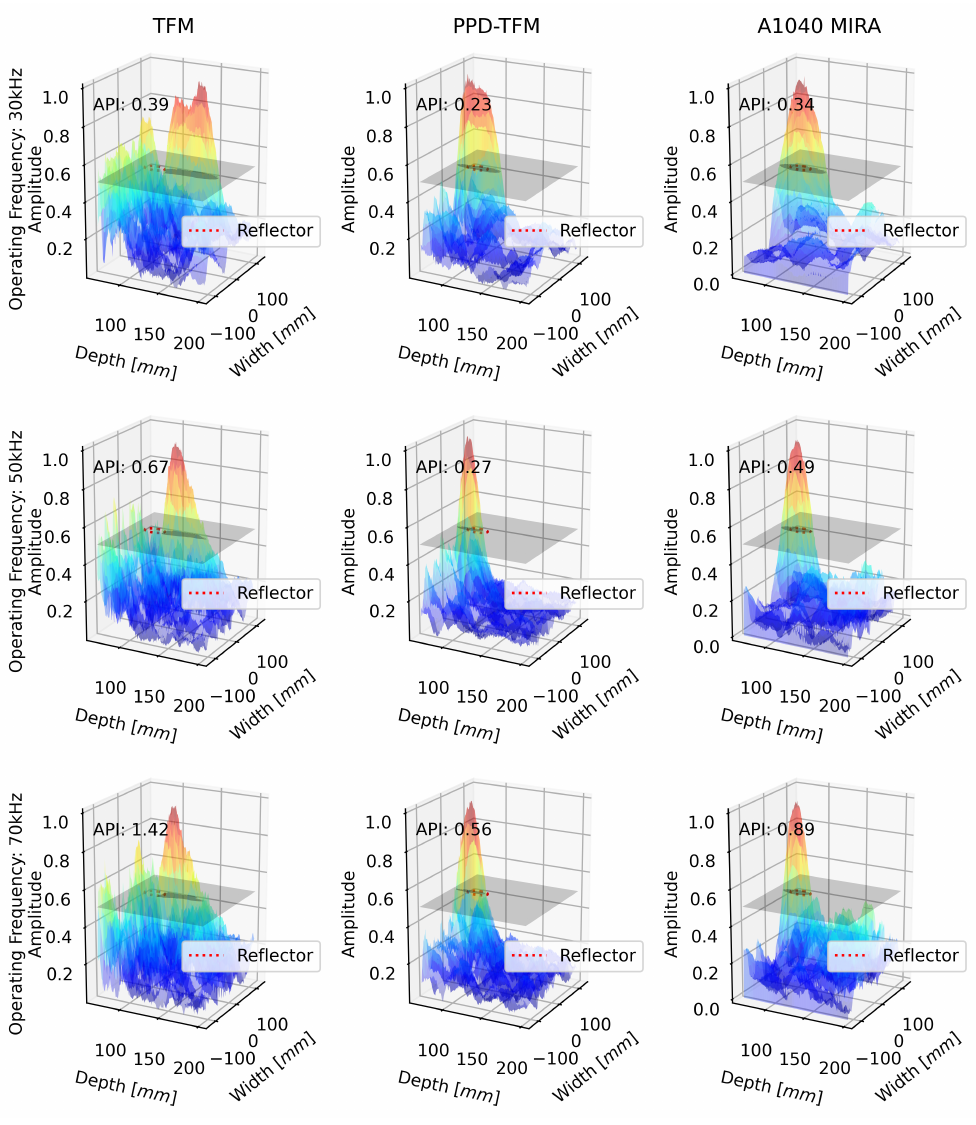
Figure 9. API for concrete cube specimen by TFM ( left ), PPD-TFM ( center ), and SAFT-C ( right ). Table 1. API values for TFM, PPD-TFM, and SAFT-C (A1040